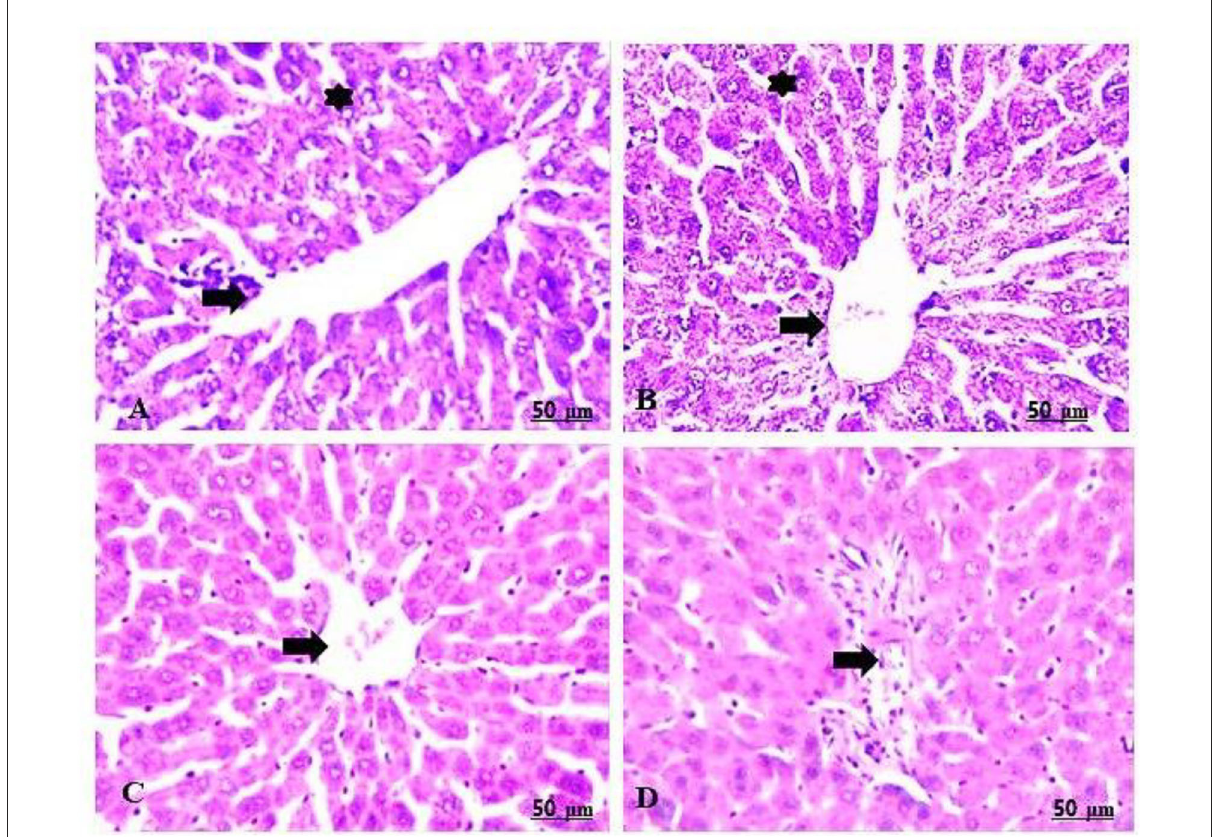
FIGURE7 (A–D) Light photomicrograph of sections from the liver of CHTiO 2 NPs exposed groups. CHTiO 2 NPs of 100 mg/kg bwt show noticeable dilatation of the central vein with perivascular mononuclear infiltration, mostly lymphocytes (arrow), also prominent vacuolation and necrosis of the hepatocytes (star) (A,B) . CHTiO 2 NPs of 300 mg/kg bwt showed congestion of the central vein and blood sinusoids (C) , and portal inflammation and fibrosis were seen (D)